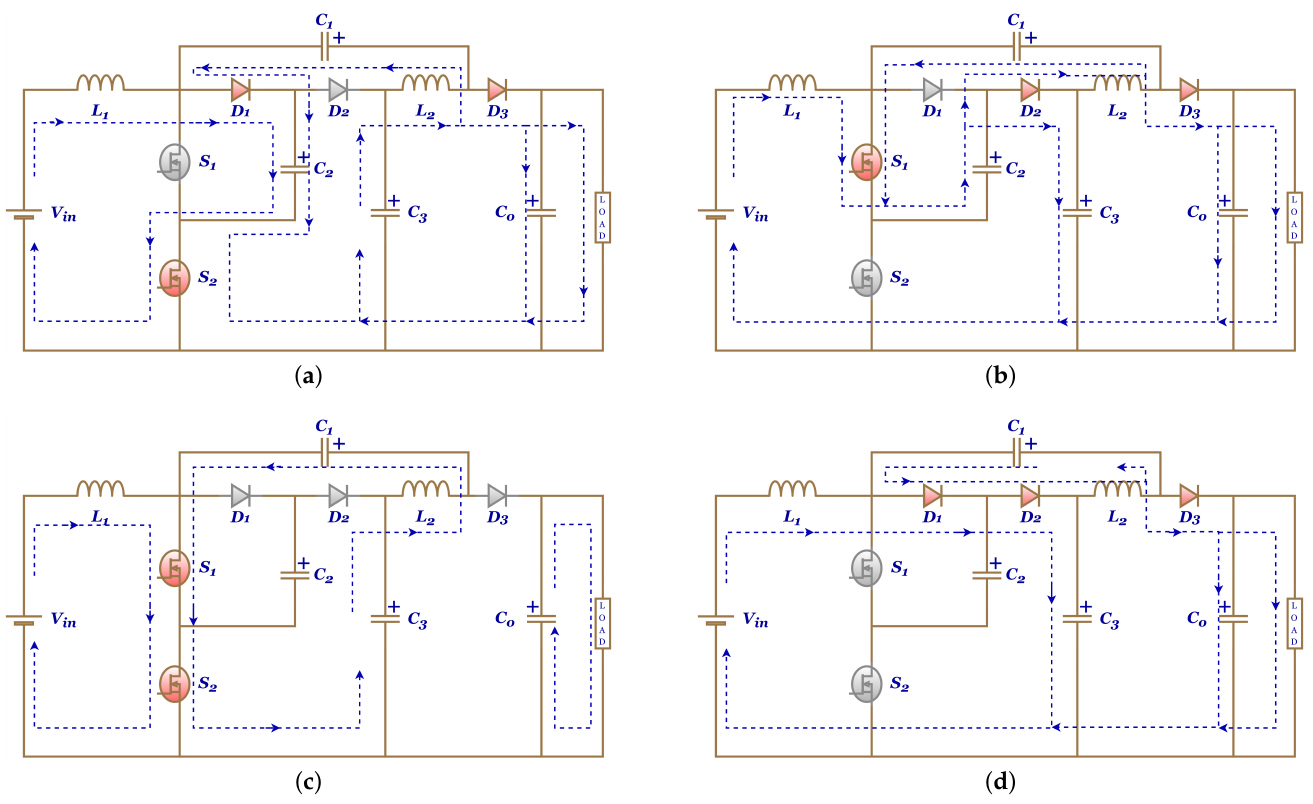
Figure 10. 2nd M-TLBC operation: ( a ) S 2 closed, ( b ) S 1 closed, ( c ) S 1 and S 2 closed, and ( d ) S 1 and S 2